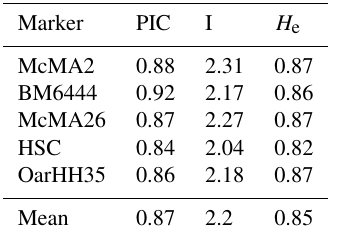
Table 3. Polymorphic information content (PIC), Shannon